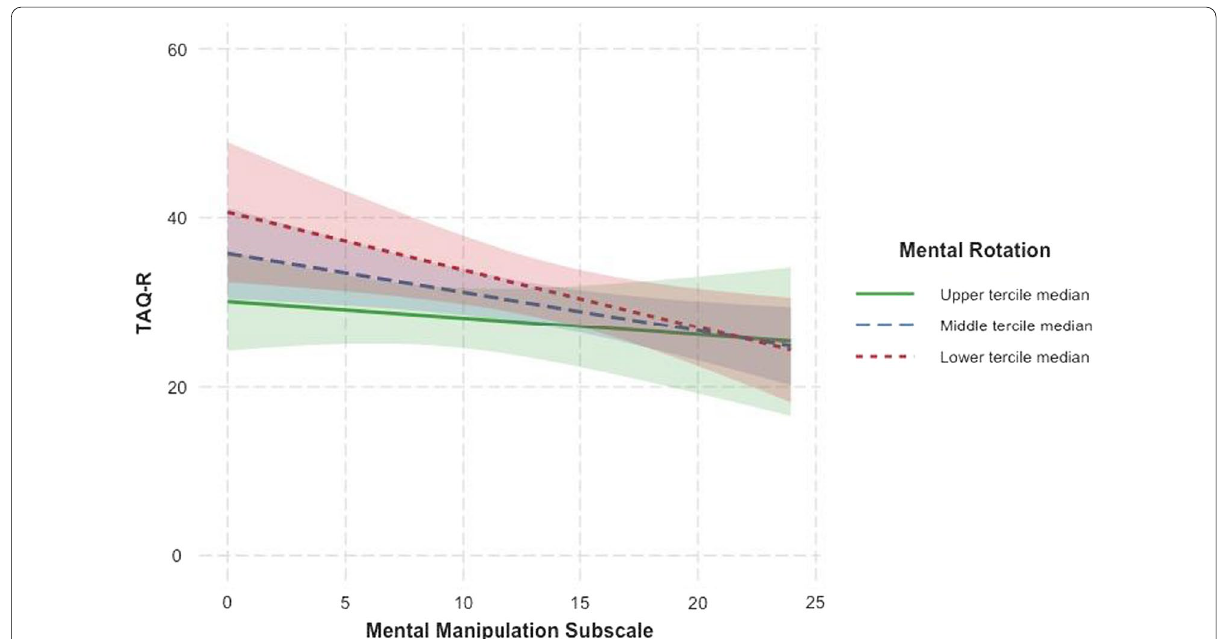
Fig. 2 The relations between teachers’ spatial skills, mental manipulation anxiety, and use of spatial pedagogical practices. Note. This graph depicts the interaction between teachers’ mental rotation score, Mental Manipulations Anxiety subscale score, and Teaching Activities Questionnaire-Revised score. Since mental rotation score is a continuous variable, the data were split into three equal-sized groups (i.e., terciles) based on teachers’ score on the assessment. The three distinct lines on the graph represent the upper, middle, and lower thirds of the distribution of teachers’ mental rotation score. The corresponding shaded regions signify the 95% confidence interval for each